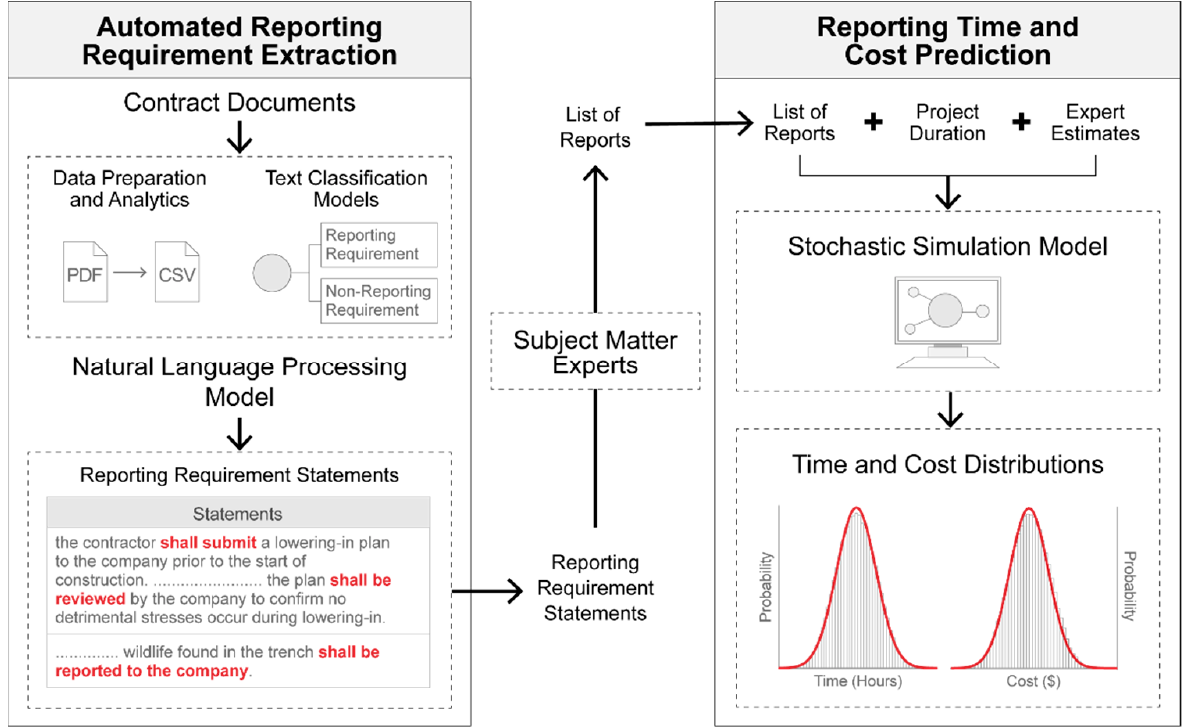
Figure 1. Proposed Framework.